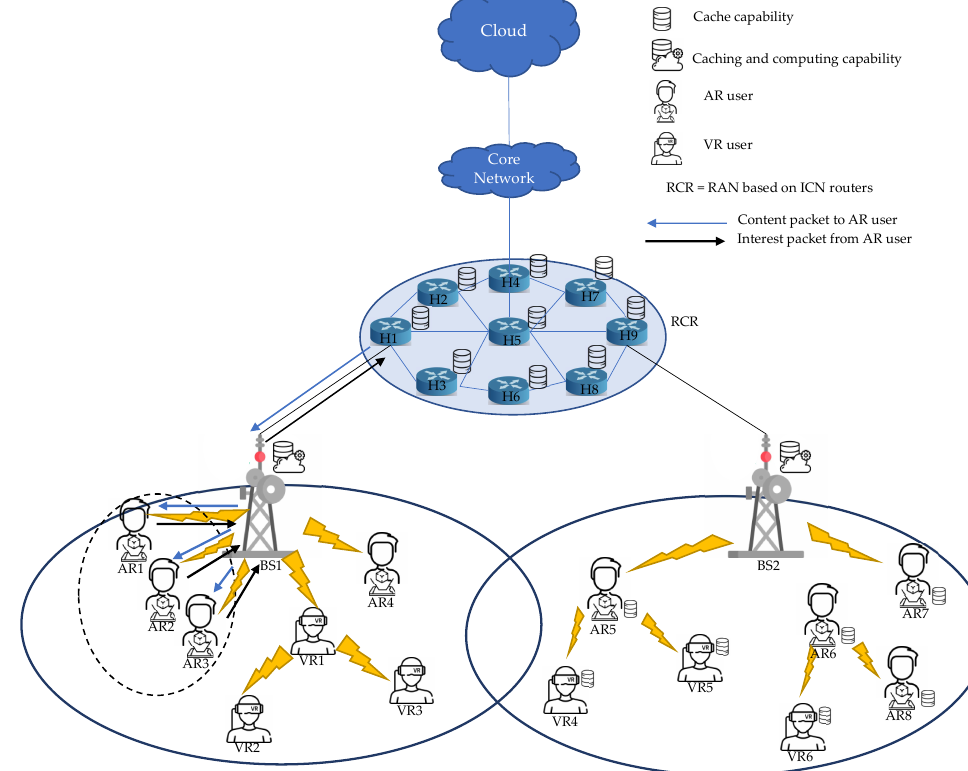
Figure 2. RL-based ISO strategy over ICN for haptic-driven AR/VR